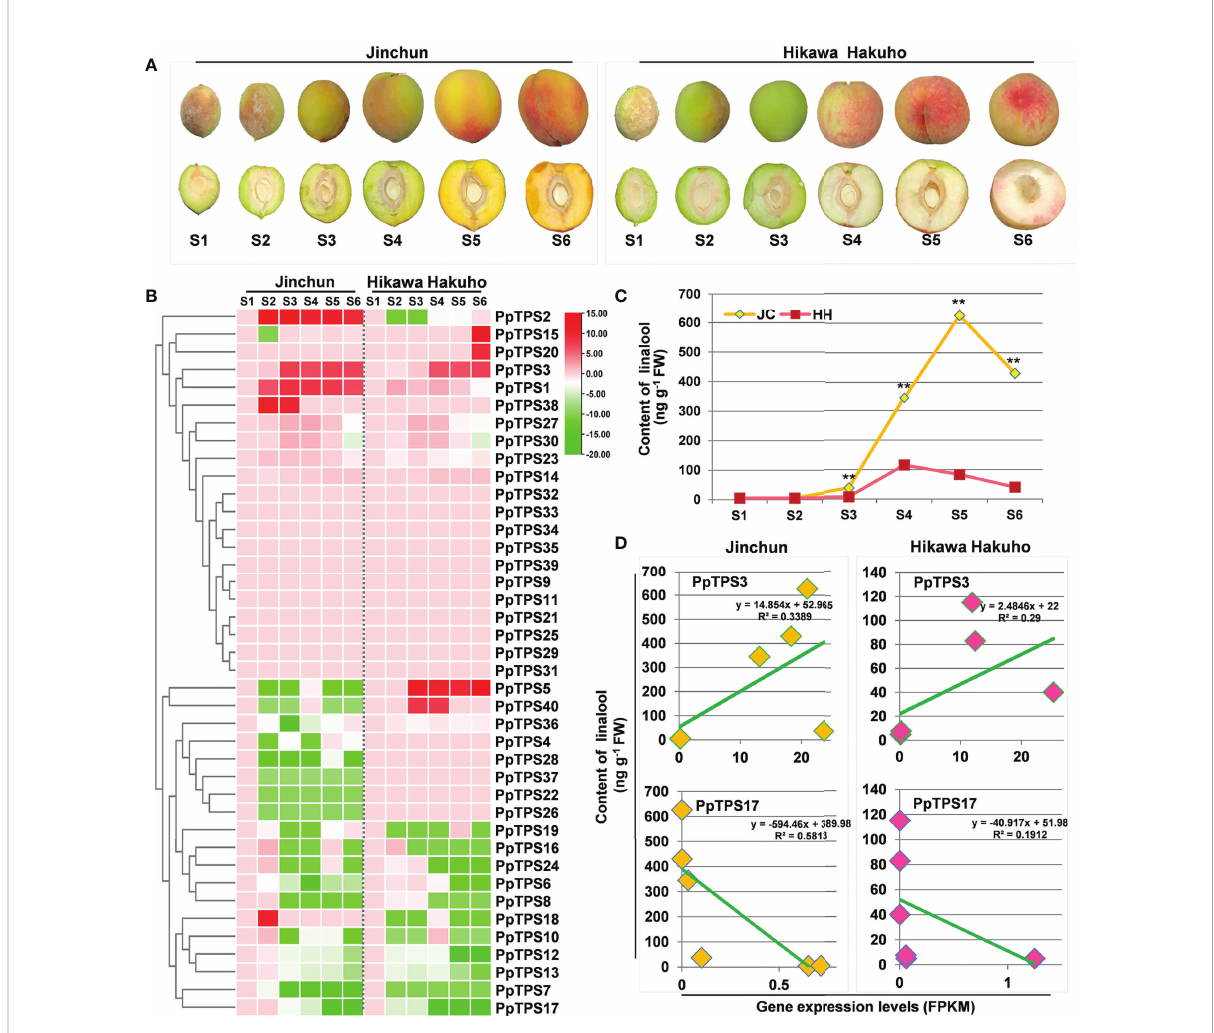
FIGURE 5 Expression pro fi les of PpTPS genes during fruit development determined by RNA sequencing. (A) Representative photographs show the peach fruits at each sampling time point. (B) A heatmap shows the relative transcript levels (FPKM value) of forty PpTPSs in fruit pulps of ‘ Jinchun ’ (JC) and ‘ Hikawa Hakuho ’ (HH) at different stages of fruit development and ripening stages (35 d (S1), 50 d (S2), 65 d (S3), 80 d (S4), 90 d (S5), 95 d (S6)). The color scale represents log (fold change, 2) values of PpTPSs transcript levels at each development stages compared with S1, with red denoting increased transcript abundance and green denoting decreased transcript abundance. The detailed FPKM values of PpTPSs during fruit development were presented in Supplementary Table 6. (C) A line graph shows the content of linalool in fruit pulps of ‘ Jinchun ’ and ‘ Hikawa Hakuho ’ at different stages of fruit development. The asterisks denote that the linalool contents in ‘ Jinchun ’ were signi fi cantly higher than that in ‘ Hikawa Hakuho ’ at each sampling time site ( p <0.05). (D) Line graphs show the linear correlations between the relative transcript levels of PpTPSs ( PpTPS3 and PpTPS17 ) and the contents of linalool in fruit pulps of ‘ Jinchun ’ and ‘ Hikawa Hakuho ’ during fruit